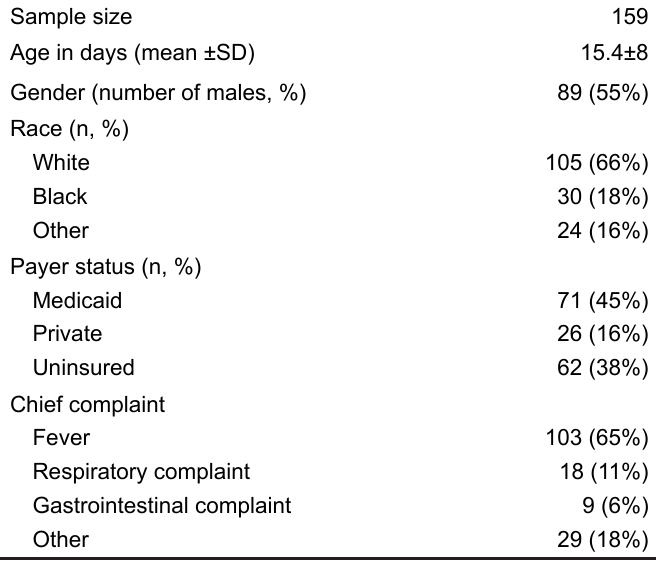
Table 1. Patient characteristics and presenting